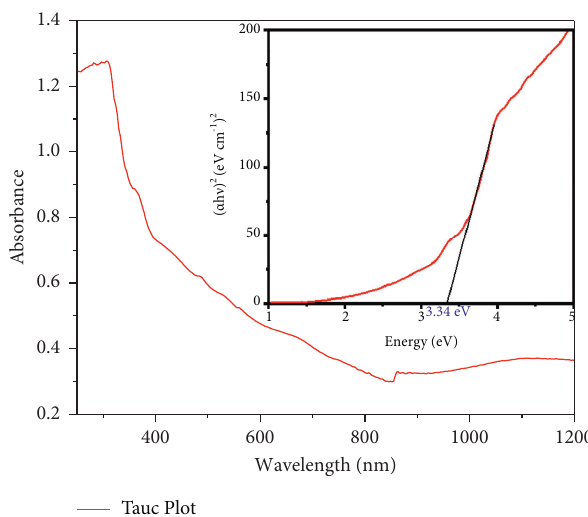
Figure 3: DRS spectrum (inset: Tauc plot) of NiO-ZnO NC.